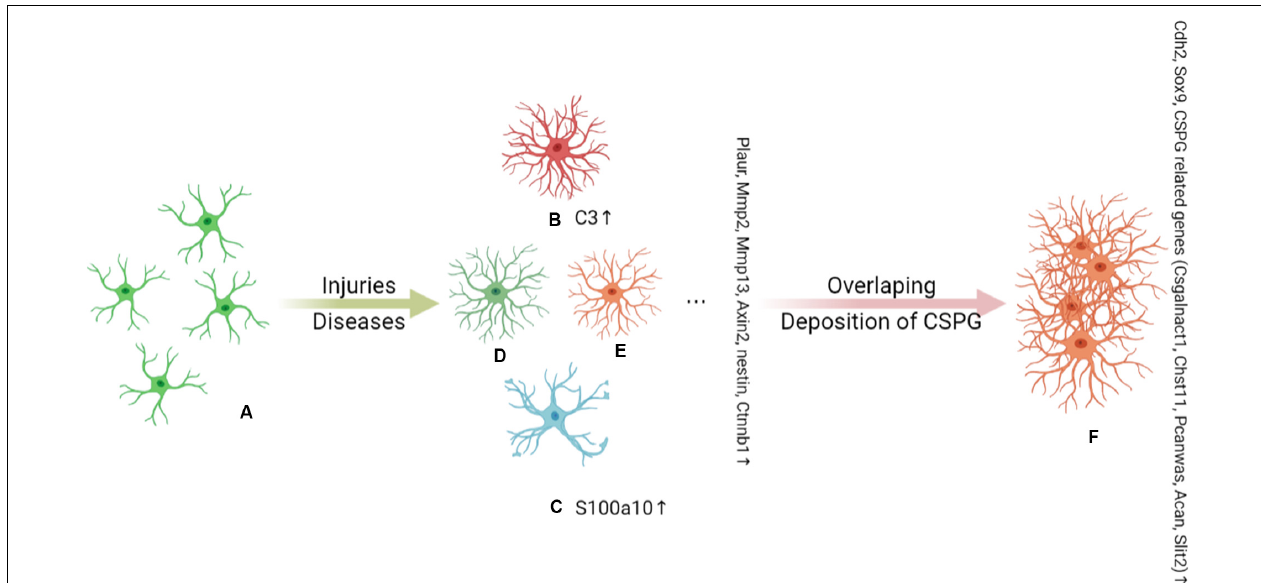
FIGURE 1 | Under the stimulation of injury and disease, (A) naive astrocytes are activated into functionally heterogeneous reactive astrocytes (RAs); this heterogeneity is determined by the background of the astrocytes. The Plaur , Mmp2 , Mmp13 , Axin2 , Nes , and Ctnnb1 genes are markers of RAs. In an inflammatory background, (B) A1 astrocytes are proposed to be a subpopulation of neurotoxic RAs and are marked by C3 expression. (C) A2 astrocytes are induced by ischemia and hypoxia and are indicated to play a neuroprotective role in injury and disease. A2 astrocytes can be distinguished by the expression of S100A10. C3 + A1 astrocytes have long dendrites, while S100a10 + A2 astrocytes have hypertrophic cell bodies with few dendrites. There are other as yet unidentified subpopulations of RAs that also play an important role in disease, such as (D) and (E) . As the disease progresses, there is an overlap of RA subpopulations and chondroitin sulfate proteoglycan (CSPG) deposits, which together induce the conversion of RAs to SAs (F) . Cdh2 , Sox9 , and CSPG-related genes ( Csgalnact1 , Chst11 , Pcan , Acan , and Slit2 ) are markers of scar-forming astrocytes